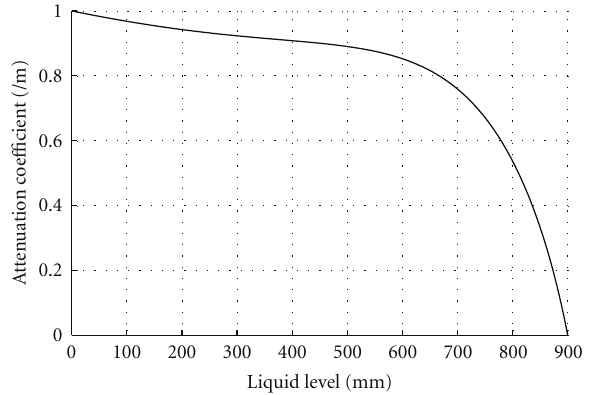
Figure 11: Simulation of sensor’s output.